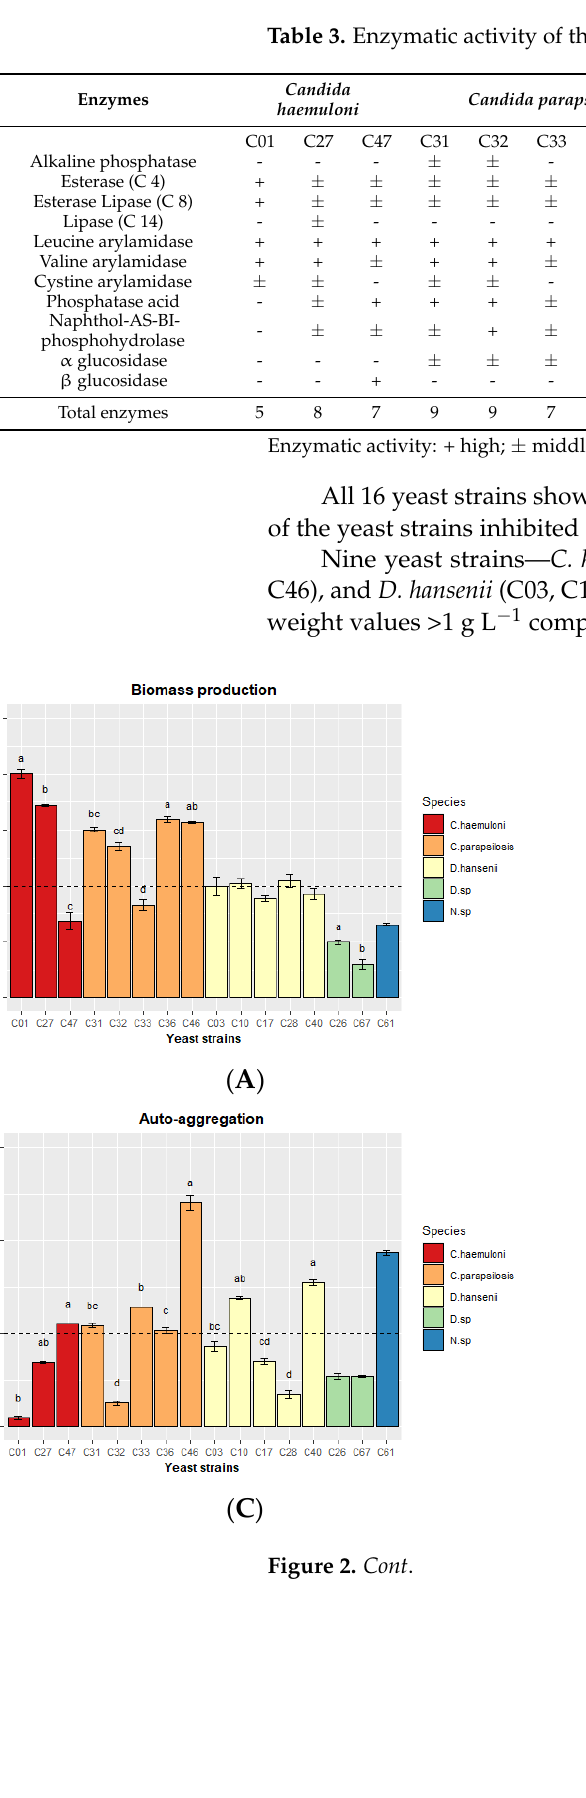
( F ) Figure 2. Different in vitro properties of the 16 yeast strains. ( A ) Biomass production (dry weight), ( B ) biofilm production, ( C ) autoaggregation at 1 h, ( D ) hydrophobicity, ( E ) electron acceptance, and ( F ) electron donation. The results are presented as the mean ± standard error. Different letters indi- cate significant differences ( p < 0.05) between yeast strains of the same species. The dash line indi- cates the arbitrary criteria for the selection of yeasts. We then analyzed several in vitro tests related to the ability of a microorganism to interact with the intestinal mucosa: biofilm production, autoaggregation, hydrophobicity, and a test to identify electron donors vs. electron acceptors. All C. parapsilosis, C. haemuloni C01 and C27 , and Debaryomyces sp. C67 produced biofilm after 48 h of cultivation (Figure 2B). Autoaggregation (> 20%) was detected after 1 h in 8 yeast strains: C. haemuloni C47;